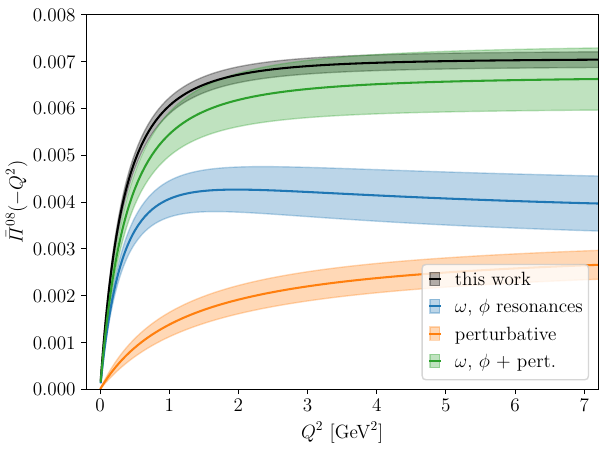
Figure 16 . HVP mixing function ¯ Π 08 as a function of Q 2 from our lattice computations, compared to the phenomenological model described in appendix D. Two contributions to the model are also shown in isolation: the finite perturbative QCD one, and the narrow resonances one resulting from the ω and φ mesons with opposite